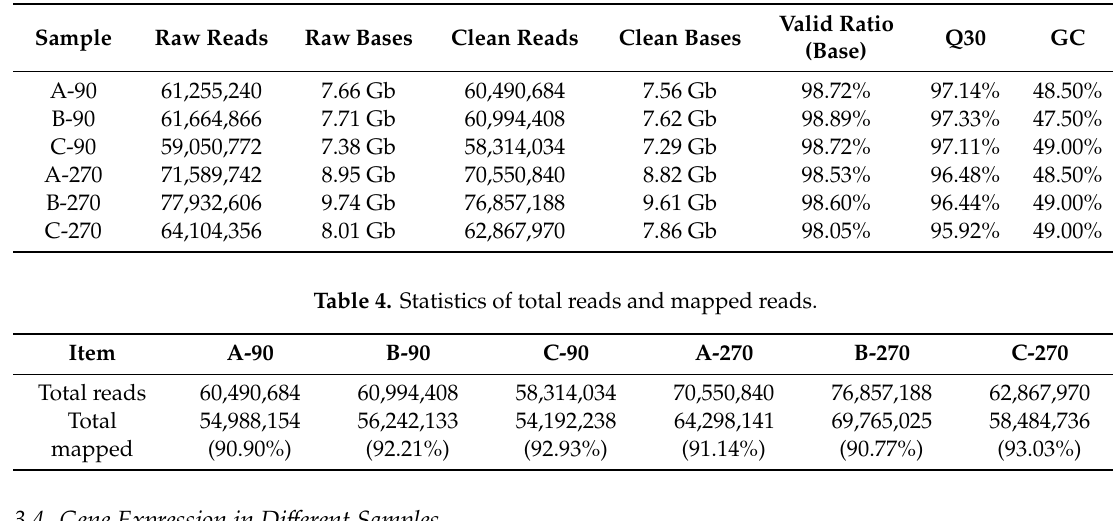
Table 3. Basic information of sequencing reads and bases.